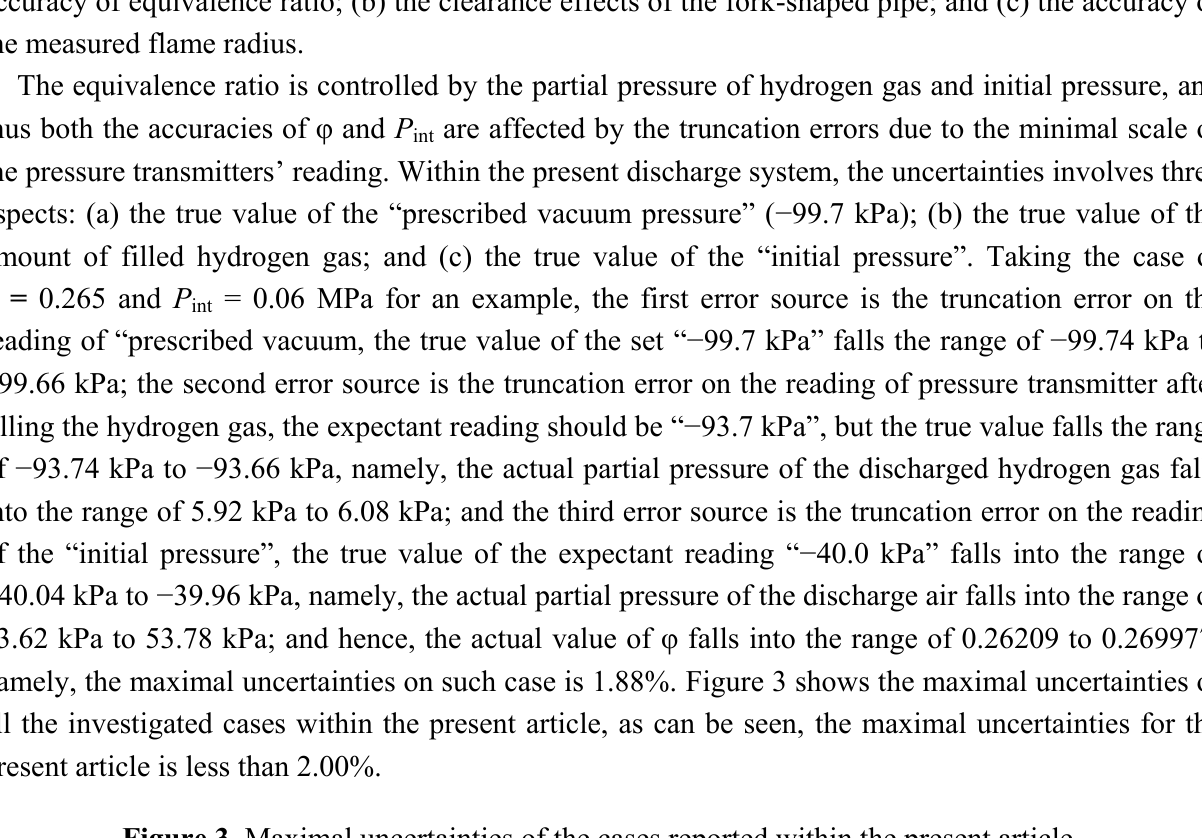
Figure 3. Maximal uncertainties of the cases reported within the present